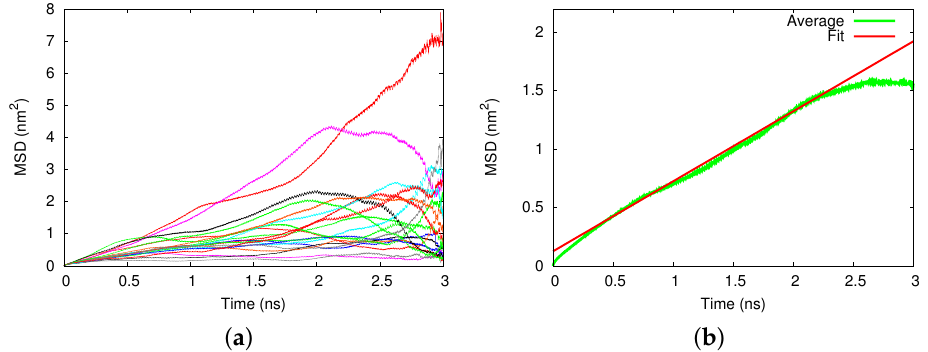
Figure 2. Diffusionof cisplatinin thegold nanopore. ( a )Mean squareddisplacement(MSD) of20 individual 3-ns diffusion runs. ( b ) Average over the individual runs, compared to a fit line, Equation (1).